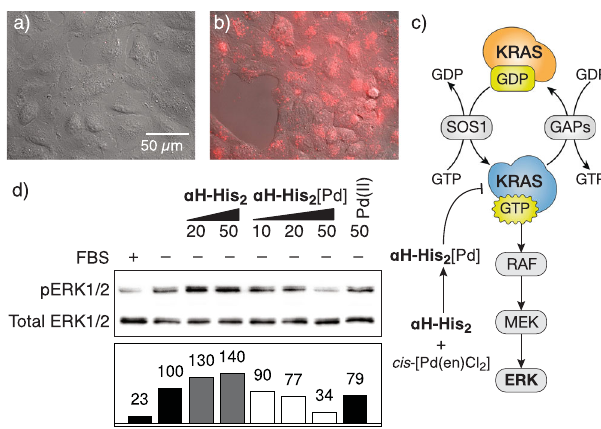
Fig. 6 α H-His 2 [Pd] is internalized and promotes the inhibition of the MAPK kinase cascade. a , b Effect of Pd(II) coordination in cellular internalization (A549 cells). a Incubation with α H-His 2 (10 µ M, 30 min at 37 °C); b incubation with the preformed α H-His 2 [Pd] complex, prepared by mixing an equimolar mixture of α H-His 2 and cis -PdCl 2 (en) in water for 10 min (10 μ M, 30 min at 37 °C). The cells were washed with PBS before being observed under the microscope. Incubations were made in Dulbecco´s modi fi ed Eagle medium (DMEM) completed with 5% of fetal bovine serum (FBS-DMEM). λ exc = 550 nm, λ em = 590-650 nm; c Scheme of the MAPK pathway and the proposed inhibition of the SOS1-mediated activation of KRAS by α H-His 2 [Pd] that should lead to reduced phosphorylation of ERK; d Addition of cis -PdCl 2 (en) to α H-His 2 led to a palladium peptide complex that inhibits the RAF-MEK-ERK mitogen- activated protein kinase (MAPK) pathway downstream of KRAS in living cells, as deduced from the decrease in the amount of phosphorylated pERK. Serum-starved A549 cells were incubated either with α H-His 2 , the preformed metallopeptide α H-His 2 [Pd], or with cis -PdCl 2 (en) at the indicated doses for 4 h. Cellular lysates were subjected to Western blot analysis by using antibodies to phospho- and total ERK1/2. Densitometry measurement of the Western blot bands. The ratio between phospho- ERK1/2 and total ERK1/2 are indicated as fold change with respect to activation conditions (without FBS, lane 2). Activation percentage is shown above each column. Original WB and micrographies available as Supplementary Data